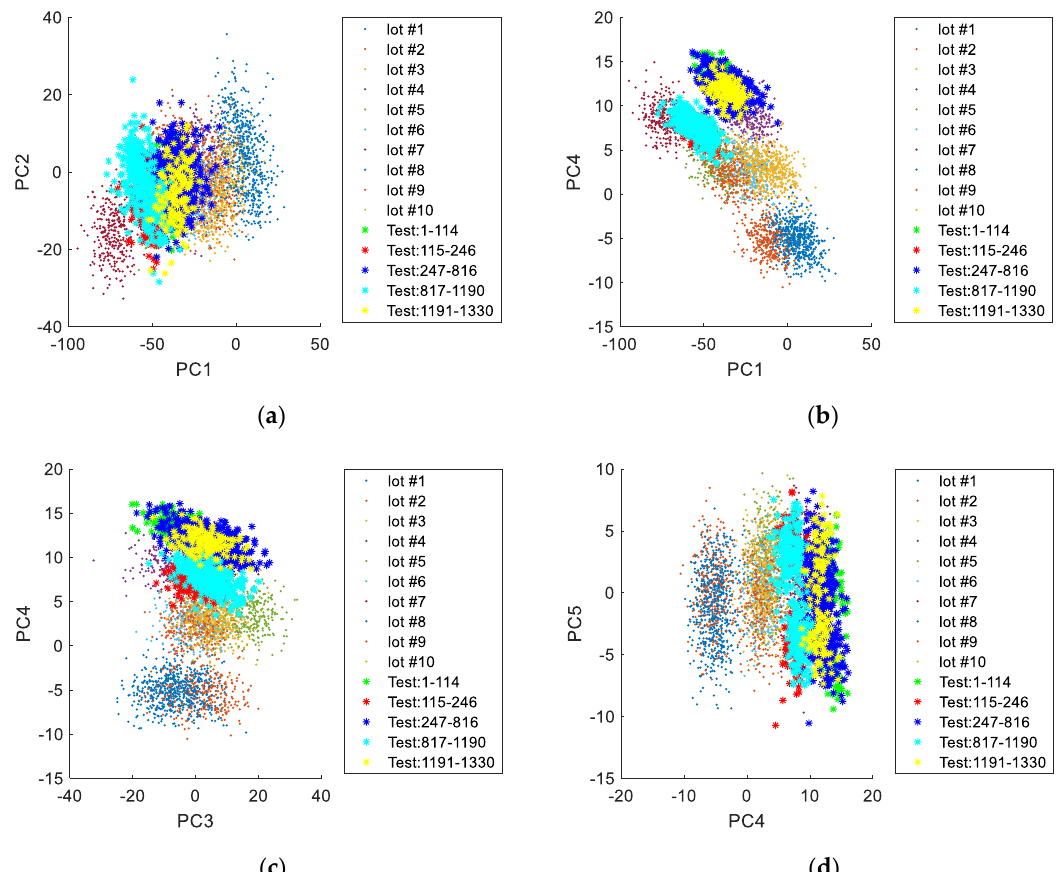
Figure 17. Relation between the principal components of the simulated validation lots and the data from CS3: ( a ) first and second principal components; ( b ) first and fourth principal components; ( c ) third and fourth principal components; ( d ) fourth and fifth principal components.